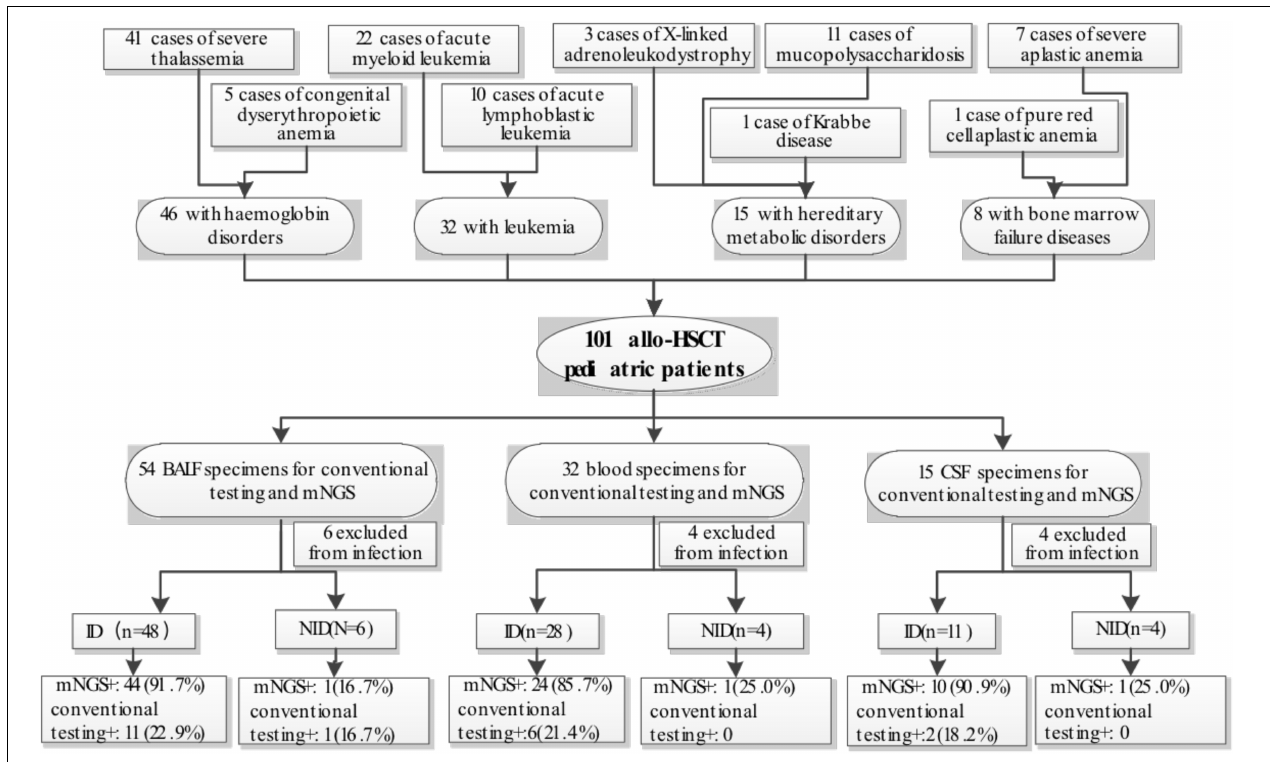
FIGURE 1 | Detailing the characteristic of patient